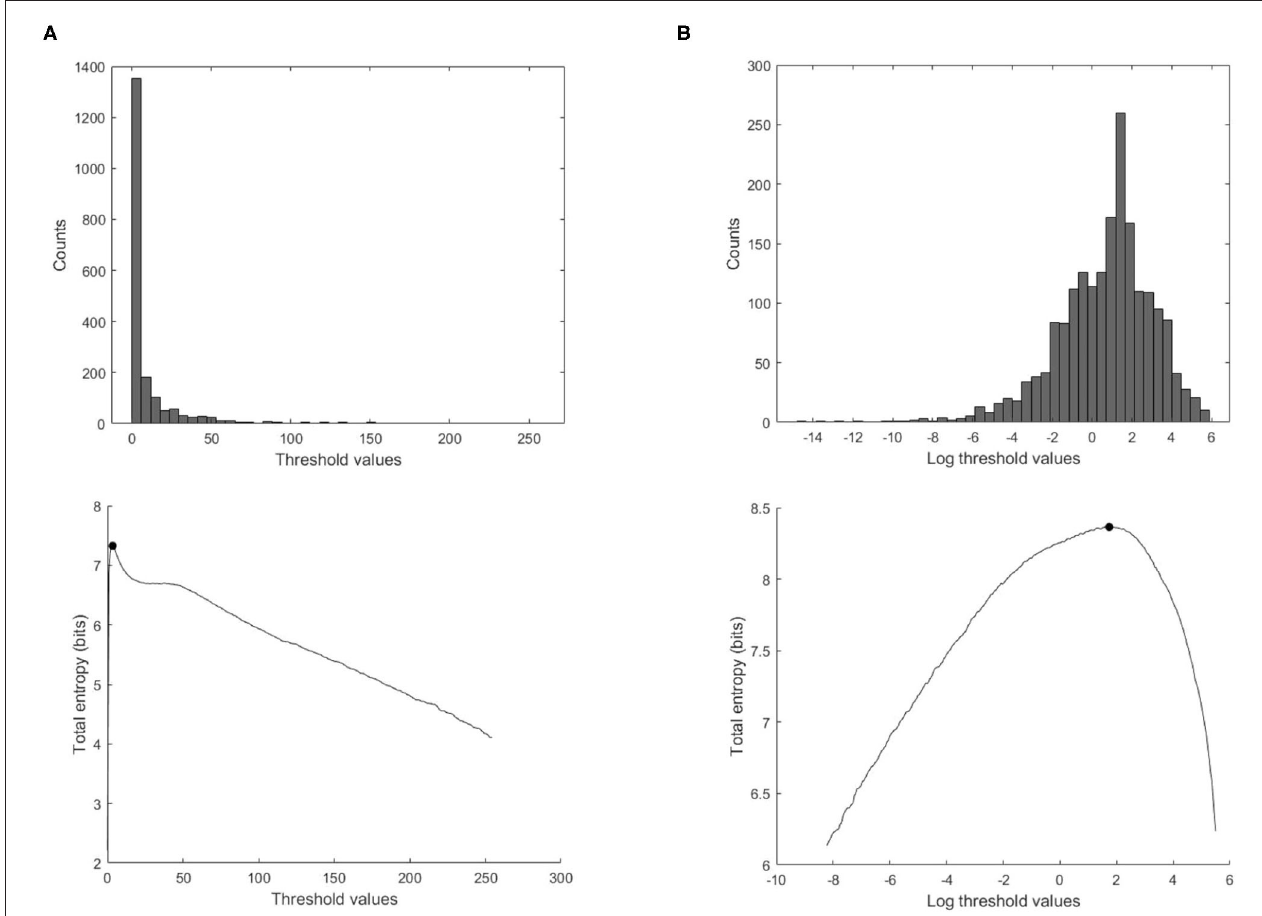
FIGURE 3 | Effect of using the log transform data on the calculation of the total entropy. (Top) Histogram of the ensemble wave intensity data of a control subject. (Bottom) Total entropy as a function of the threshold calculated on the wave intensity data, with the optimal threshold indicated with the black solid circle, (A) threshold values in the original units, (B) threshold values transformed to the logarithmic